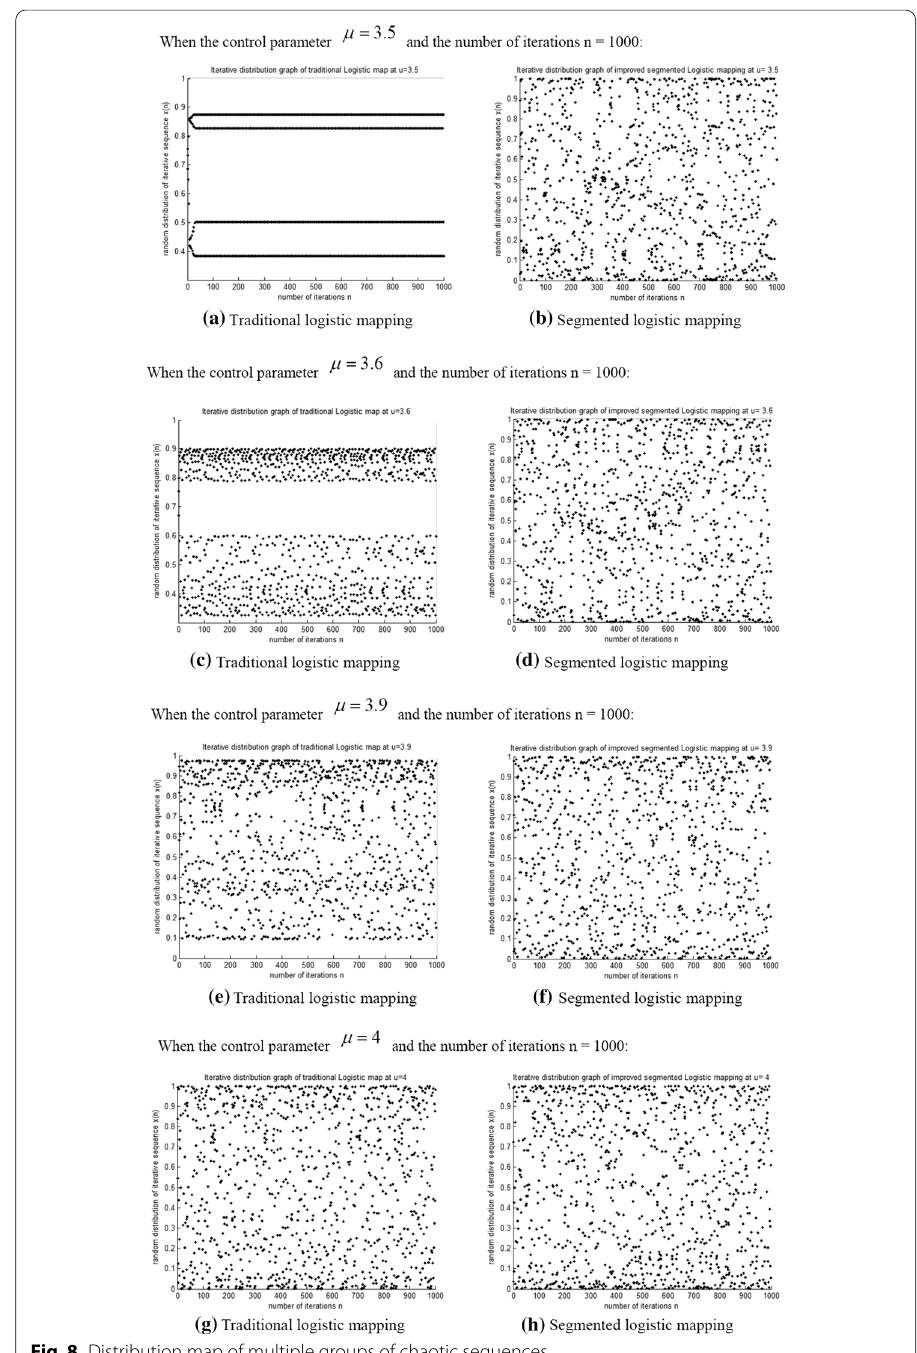
Fig. 8 Distribution map of multiple groups of chaotic